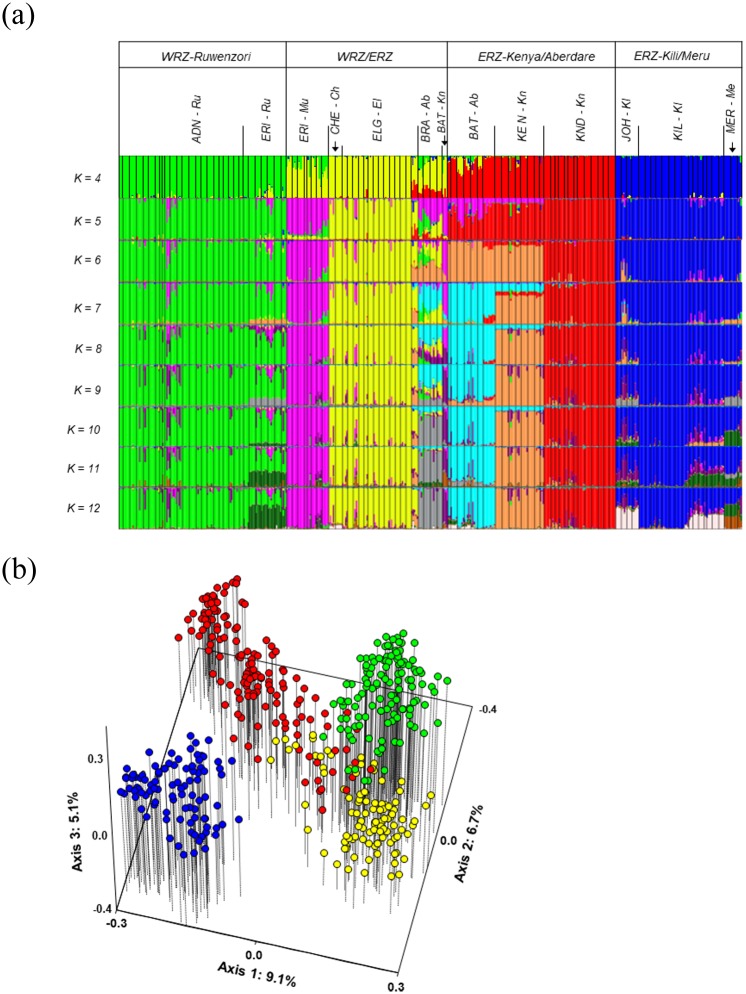
(a) Assignment of the 460 individual plants in the total AFLP dataset to genetic groups using STRUCTURE analyses for K = 4 to K = 12. Species and mountain names are abbreviated as in Fig 2. WRZ–Western Rift Zone mountains, ERZ–Eastern Rift Zone mountains. (b) Principal Coordinates Analysis (PCoA) based on Dice’s coefficient of similarity between AFLP phenotypes in the total dataset; colours show genetic groups for K = 4.